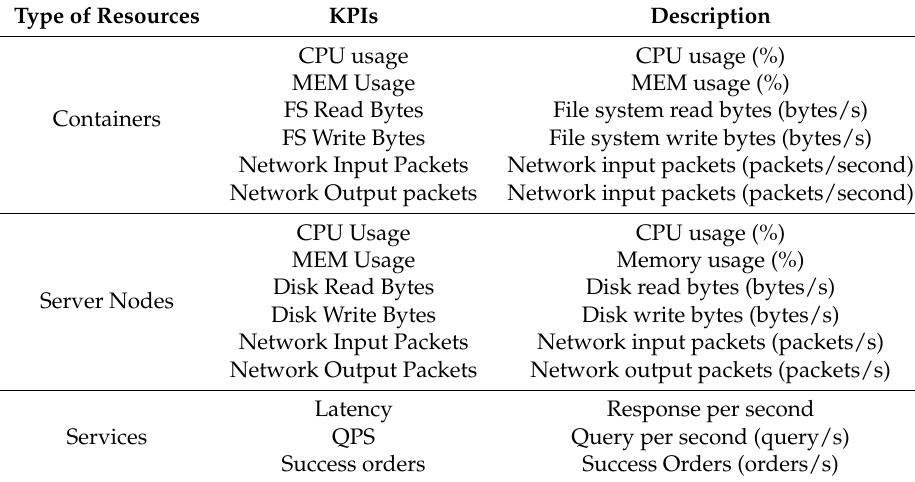
Table 1. Main monitoring